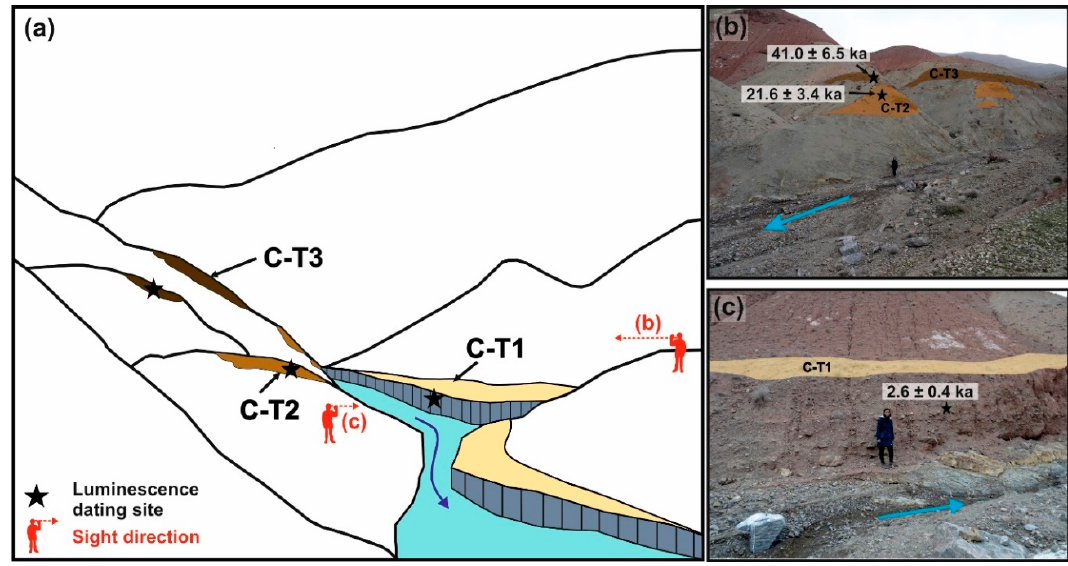
Figure 4. The studied terrace levels C-T1–C-T3 at the main eastern river in the lower catchment with luminescence ages (location in the river system please see Figure 3) ( a ) Sketch of the terrace levels seen upstream. ( b ) Terrace levels C-T2 and C-T3 at the right bank of the river. ( c ) Terrace level C-T1 at the left bank of the river. Please note the large boulders in the current river bed.